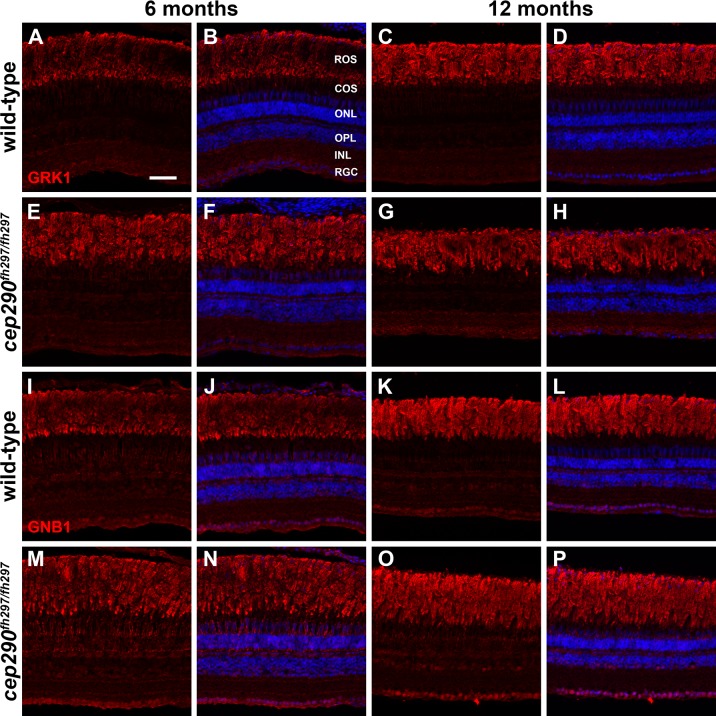
Immunolocalization of GRK1 and GNB1 in cep290fh297/fh297 mutants at 6 and 12 months of age.Retinal cryosections of cep290fh297/fh297 mutants and wild-type siblings were stained with polyclonal antibodies against rhodopsin kinase (A-H; GRK1) or with GNB1 polyclonal antibodies against the β subunit of rod transducin (I-P) to label rod outer segments at both 6 and 12 months of age. ROS, rod outer segments; COS, cone outer segments; ONL, outer nuclear layer; OPL, outer plexiform layer; INL, inner nuclear layer; RGC, retinal ganglion cells. Scale bar: 50 μm.